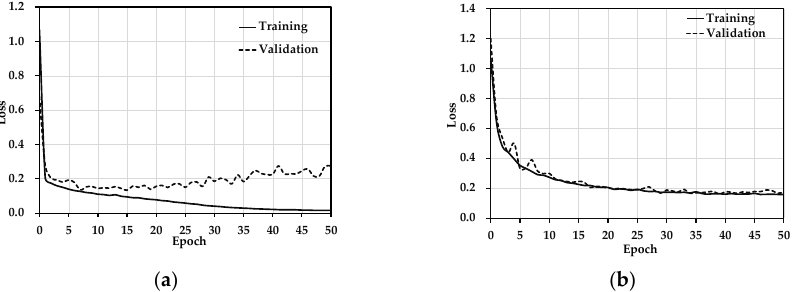
Figure 8. The MEMS pressure sensor detects the total loss of the positioning network. ( a ) Loss before data augmentation. ( b ) Loss after data